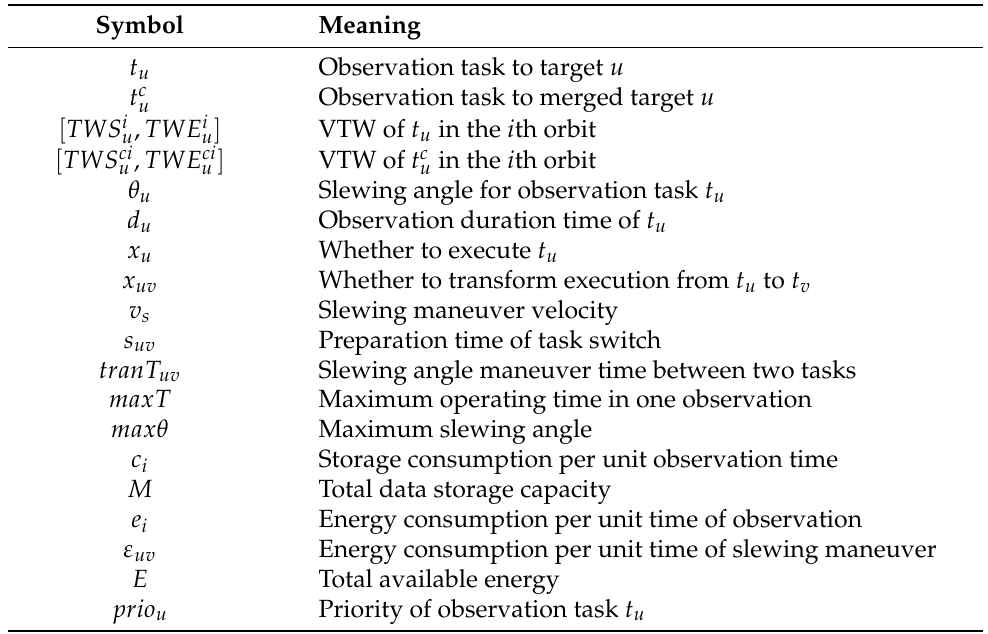
Table 1. Summary of